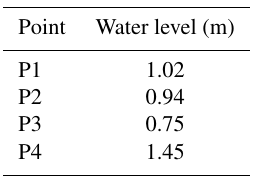
Table 5. High-water marks for points P1–P4 for the Septem- ber 2015